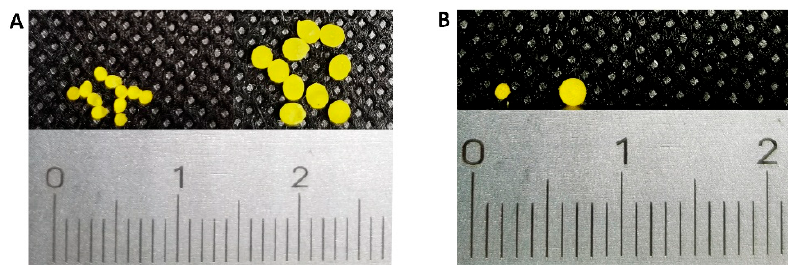
Figure 2. ( A ) Front-view of 1mm and 2mm pellets. ( B ) Top-view of each sized pellets.